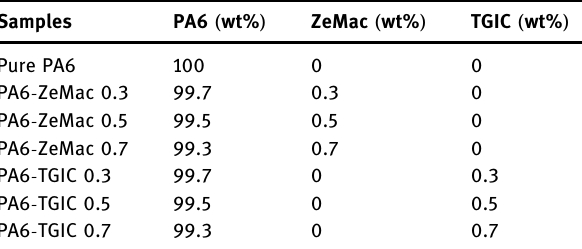
Table 2: Weight percentages of materials